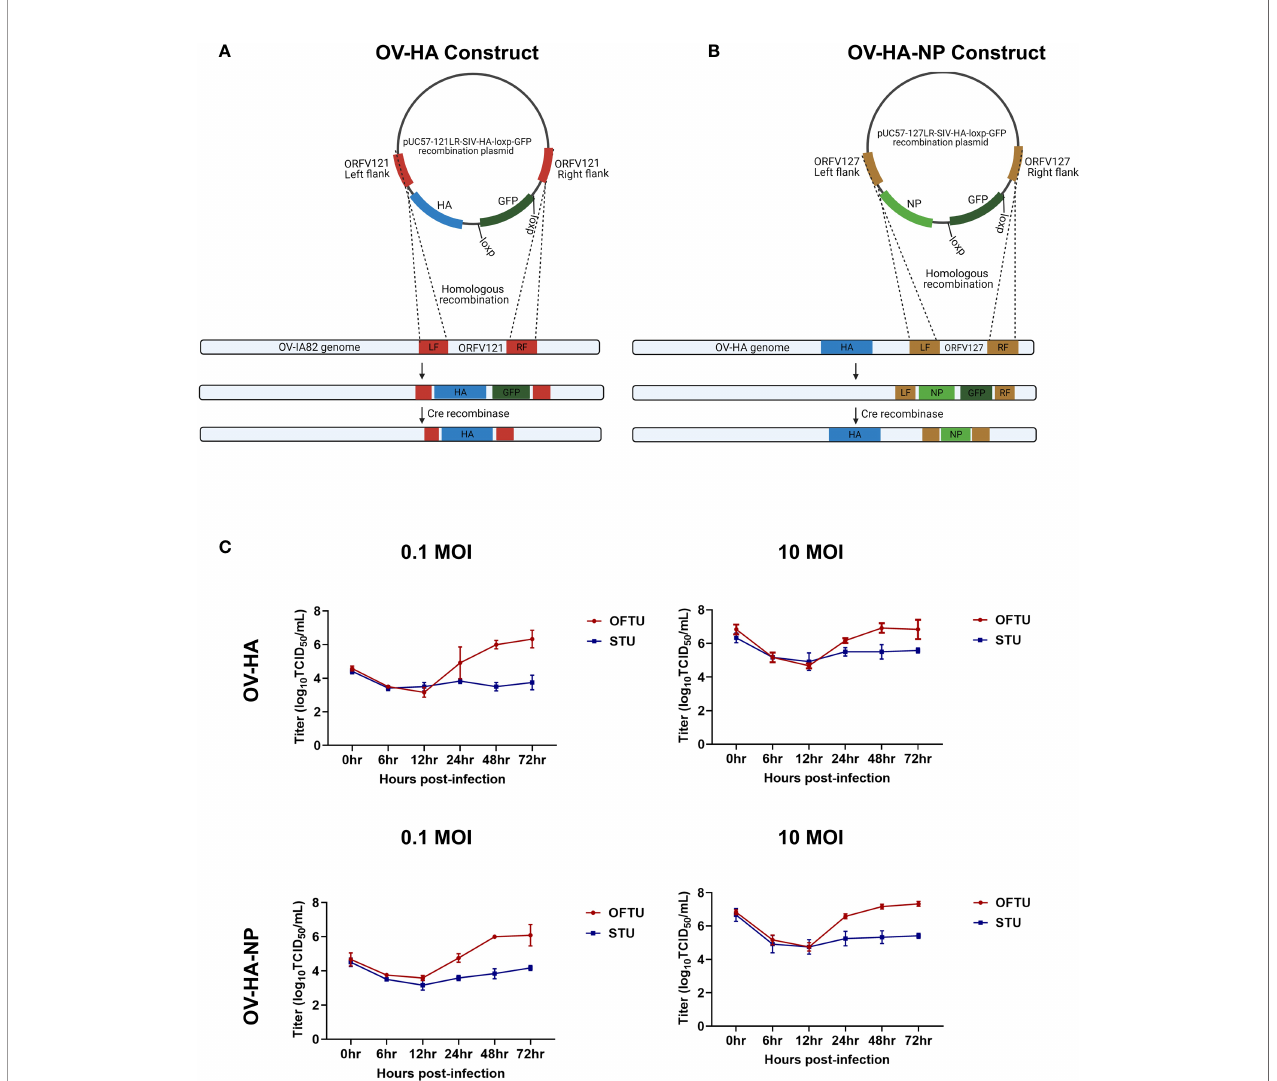
FIGURE 1 | Construction of ORFV recombinants and their replication kinetics. (A) Schematic representation of homologous recombination between pUC57-121LR- SIV-HA-loxp-GFP plasmid and ORFV-IA82 genome. The recombinant virus was treated with Cre recombinase to remove GFP marker gene to obtain markerless OV- HA construct. (B) Schematic representation of homologous recombination between pUC57-127LR-SIV-NP-loxp-GFP plasmid and OV-HA genome. The recombinant virus was treated with Cre recombinase to obtain markerless OV-HA-NP construct. (C) Multi-step (0.1 MOI) and single step (10 MOI) growth curve of OV-HA and OV-HA-NP. OFTu or STU cells were infected with OV-HA and-HA-NP recombinants and virus titers were calculated at 0, 6, 12, 24, 48 and 72 hours post-infection. Error bars represent SEM calculated based on three independent